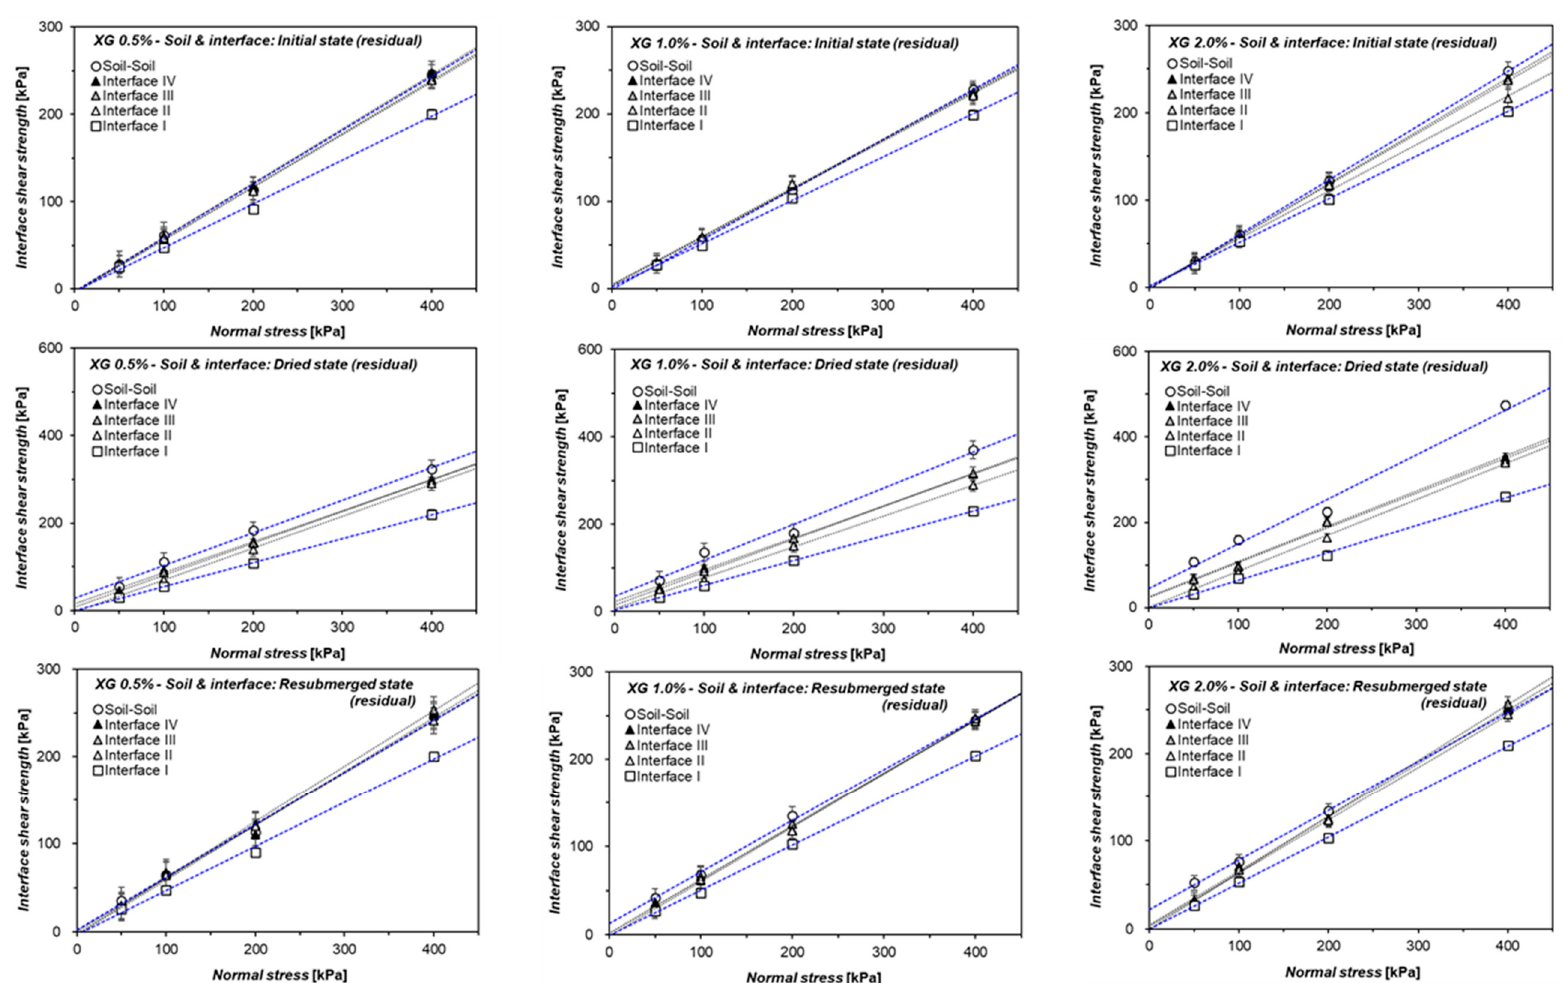
Figure 11. Residual strengths of xanthan gum-treated sand obtained from direct and interfacial shear tests.